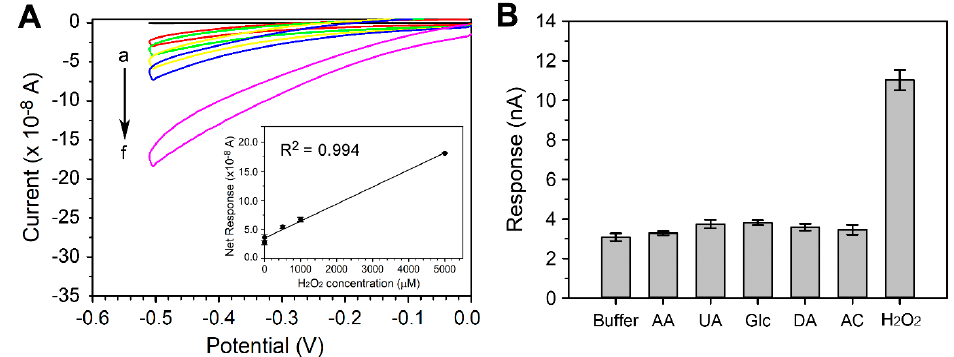
Figure 6. The electrochemical responses of H 2 O 2 on CMOS sensing chip. ( A ) The cyclic voltammograms of various concentrations of H 2 O 2 (a, no H 2 O 2 ; b, 0.1 μ M; c, 1 μ M; d, 500 μ M, e, 1 mM; f, 5 mM) on sensing chip with TiN 3D-NEA. The cyclic voltammetry (CV) was performed in a potential range of 0 V ~ − 0.5 V at the scan rate of 100 mV/s. (inset), the linear regression plot of current responses versus H 2 O 2 concentrations. ( B ) Responses of various interferants on the 3D-NEAL. The response of different interferants including 1 mM AA, 1 mM UA, 1 mM Glucose, 1 mM DA, 1 mM AC, and 1 mM H 2 O 2 was performed in a